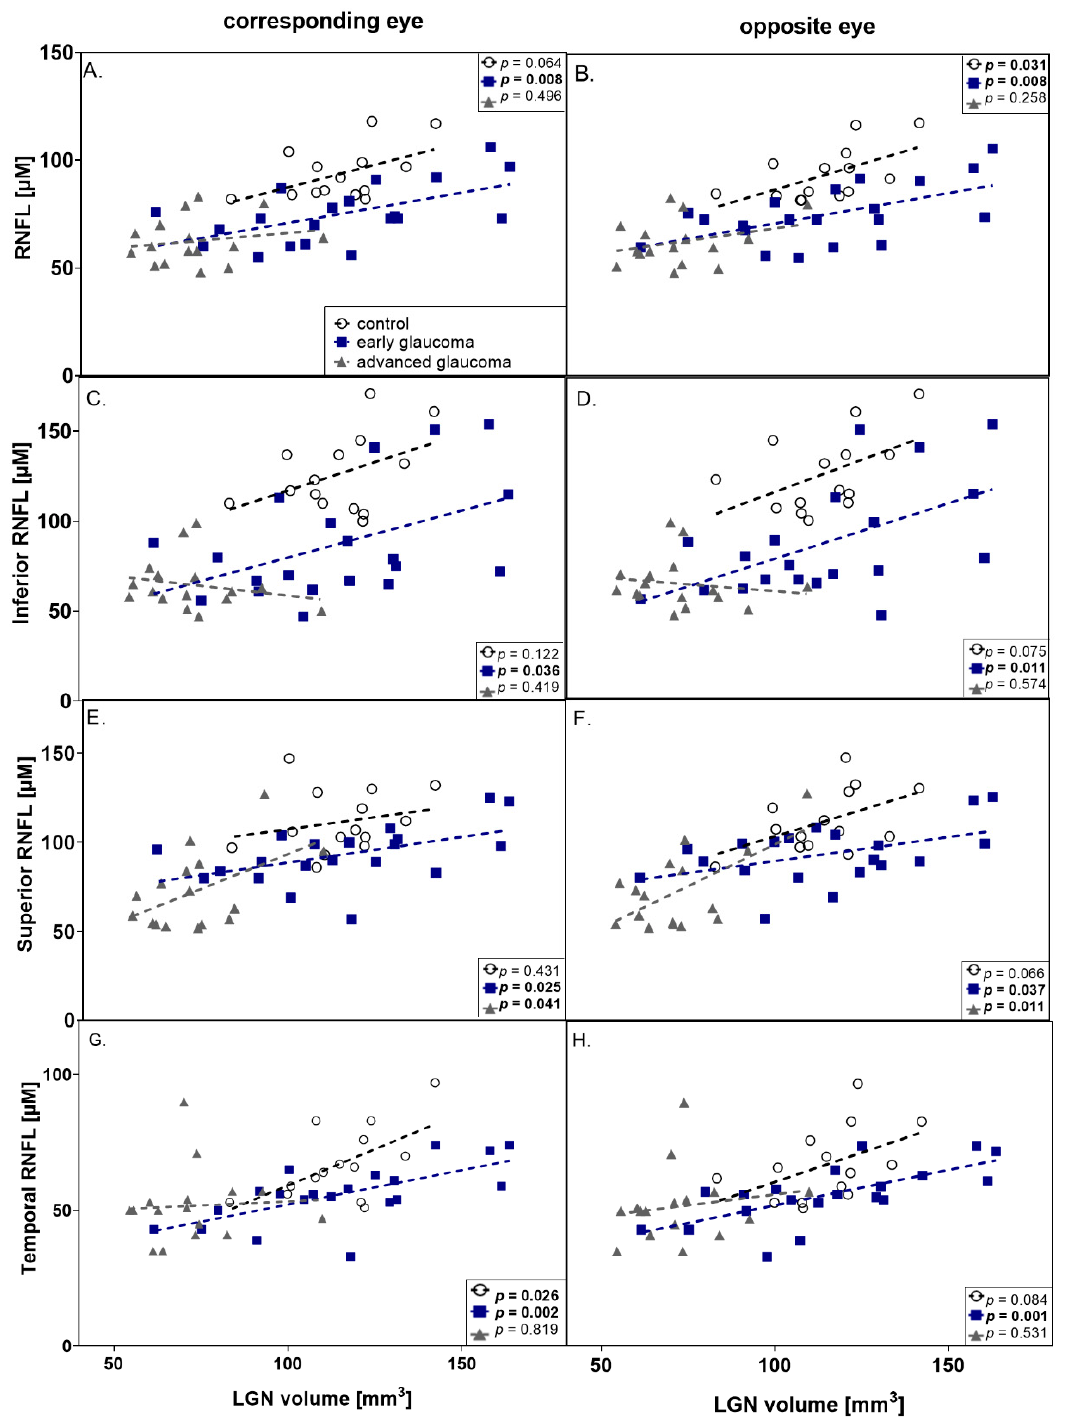
Figure 4. Graphic presentation of correlations between RNFL thickness and LGNs volume in corresponding (left column) and opposite eye (right column). ( A , B ) mean RNFL thickness; ( C , D ) inferior RNFL thickness; ( E , F ) superior RNFL thickness; ( G , H ) temporal RNFL thickness; all are correlated with LGN volume. Correlation coe ffi cients of Pearson’s (r) and Spearman’s (R) are presented in Table 5. (black dot–control group, dark blue square—early glaucoma, gray triangle—advanced glaucoma).